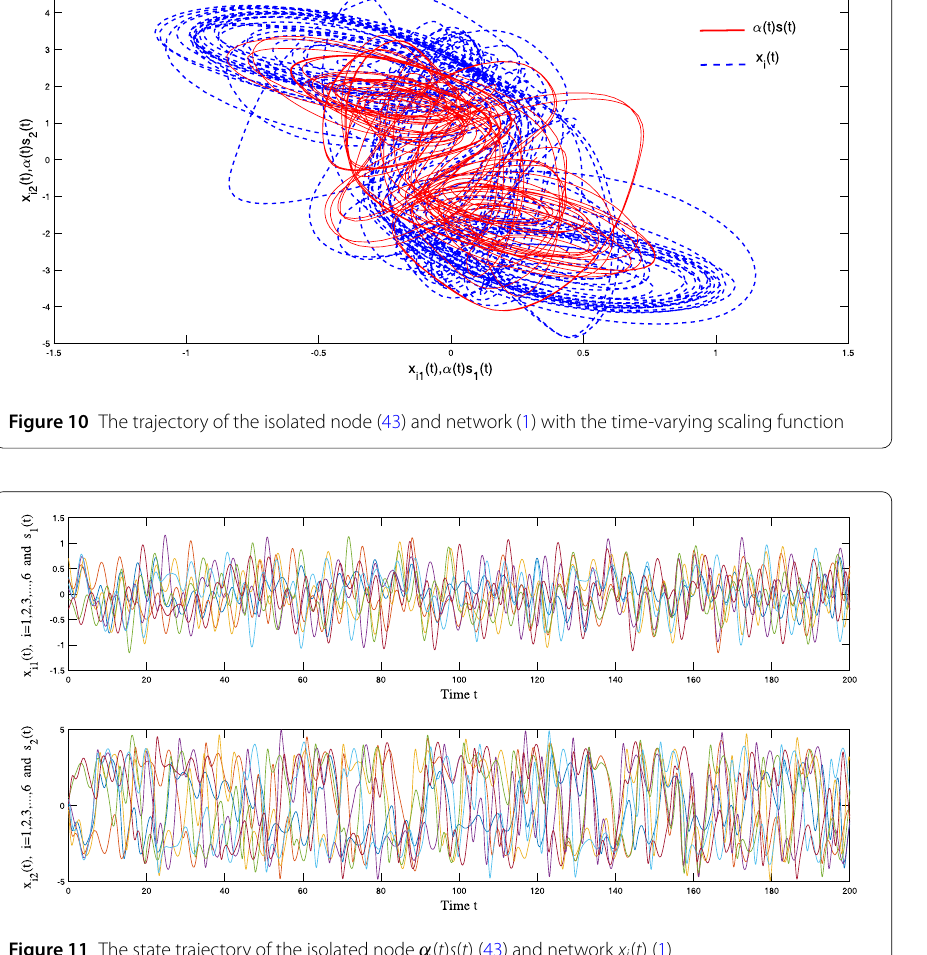
Figure 11 The state trajectory of the isolated node α ( t ) s ( t ) (43) and network x i ( t )